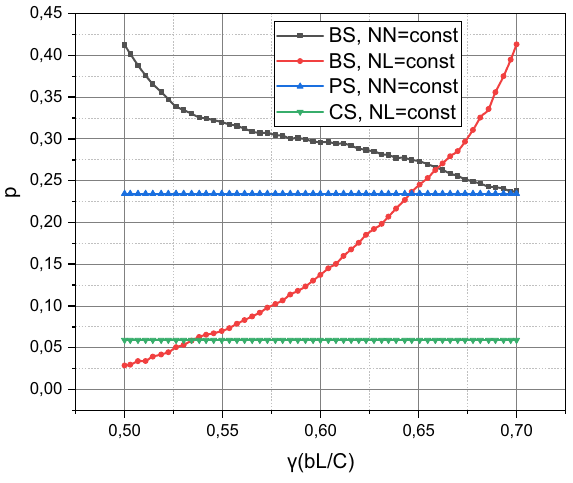
Figure 7. Dependences p = f(γ, Scheme, b L /C) .